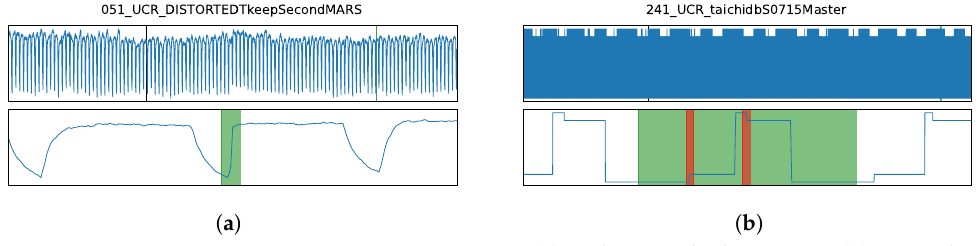
Figure 7. Time Series containing “steep increase” ( a ) and “smoothed increase” ( b ) anomalies. ( a ) Overview (top) and detail (bottom) plot of the distorted time series containing the “steep in- crease” anomaly. The ground truth anomaly is highlighted in green. ( b ) Overview (top) and detail (bottom) plot of the time series containing the “smoothed increase” anomaly. The ground truth anomaly is highlighted in green, while the sections where the smoothing is visible are highlighted in